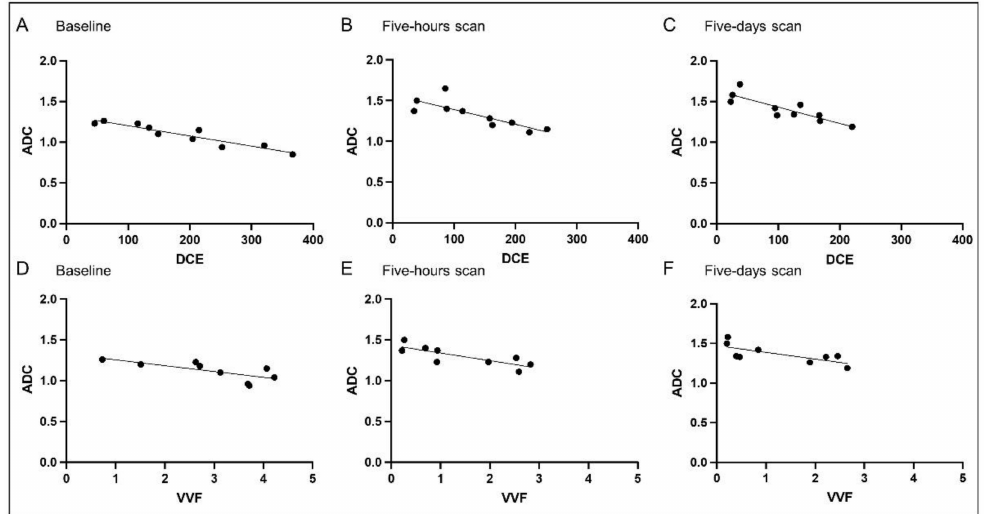
Figure 5. Correlation between DCE and ADC as well as VVF and ADC imaging parameters before and after therapy with tTF-NGR. Correlation of DCE and ADC ( A – C ) as well as VVF and ADC ( D – F ) shows a good correlation of the individual perfusion parameters with the ADC values.